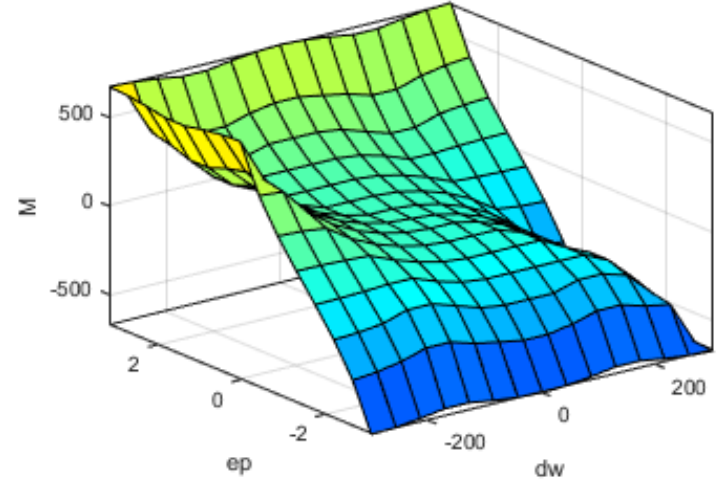
Figure 8. Surface M = f ( e θ , d ω ).